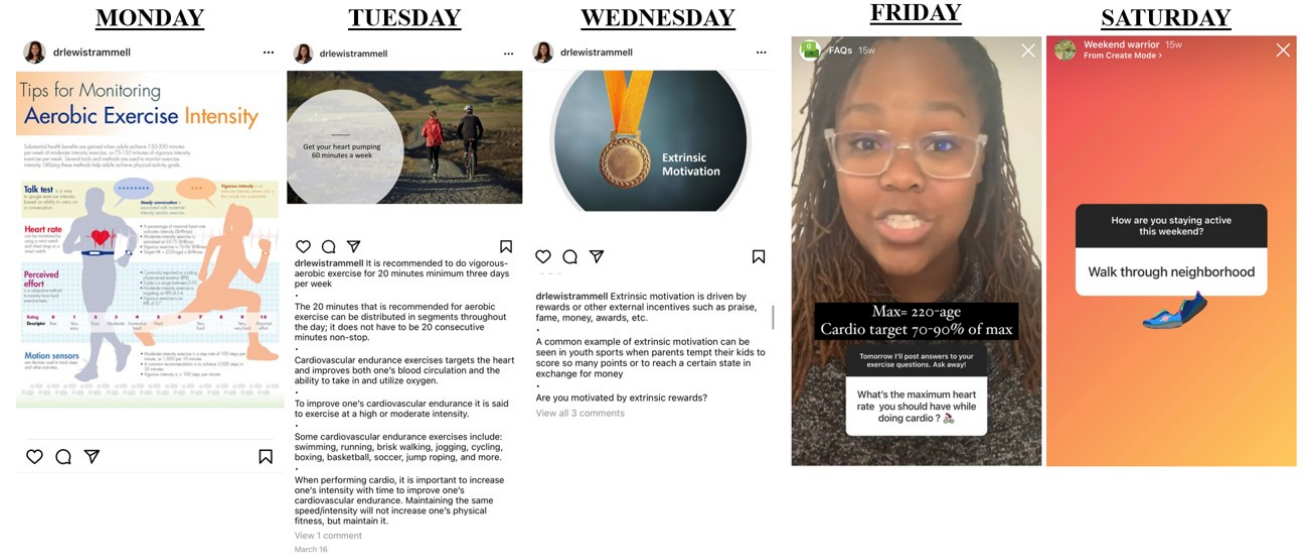
Figure 2. Sample of a Week of Intervention Content.